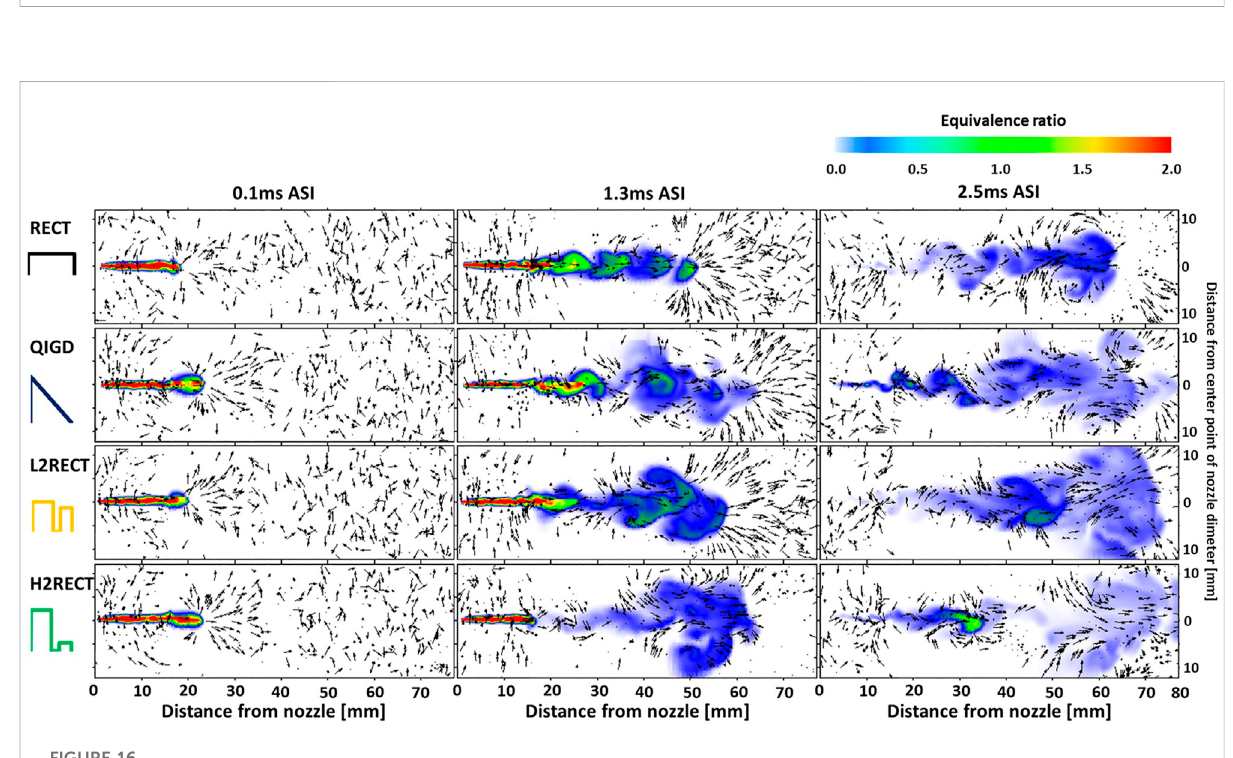
FIGURE 16 History of equivalence ratio and spray velocity vector direction at various injection